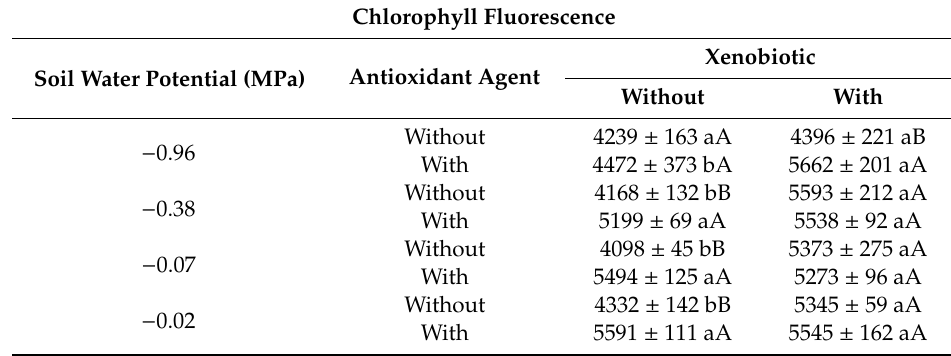
Table 6. Chlorophyll fluorescence in soybean plants submitted to di ff erent soil water potentials and xenobiotic and antioxidant agent applications.